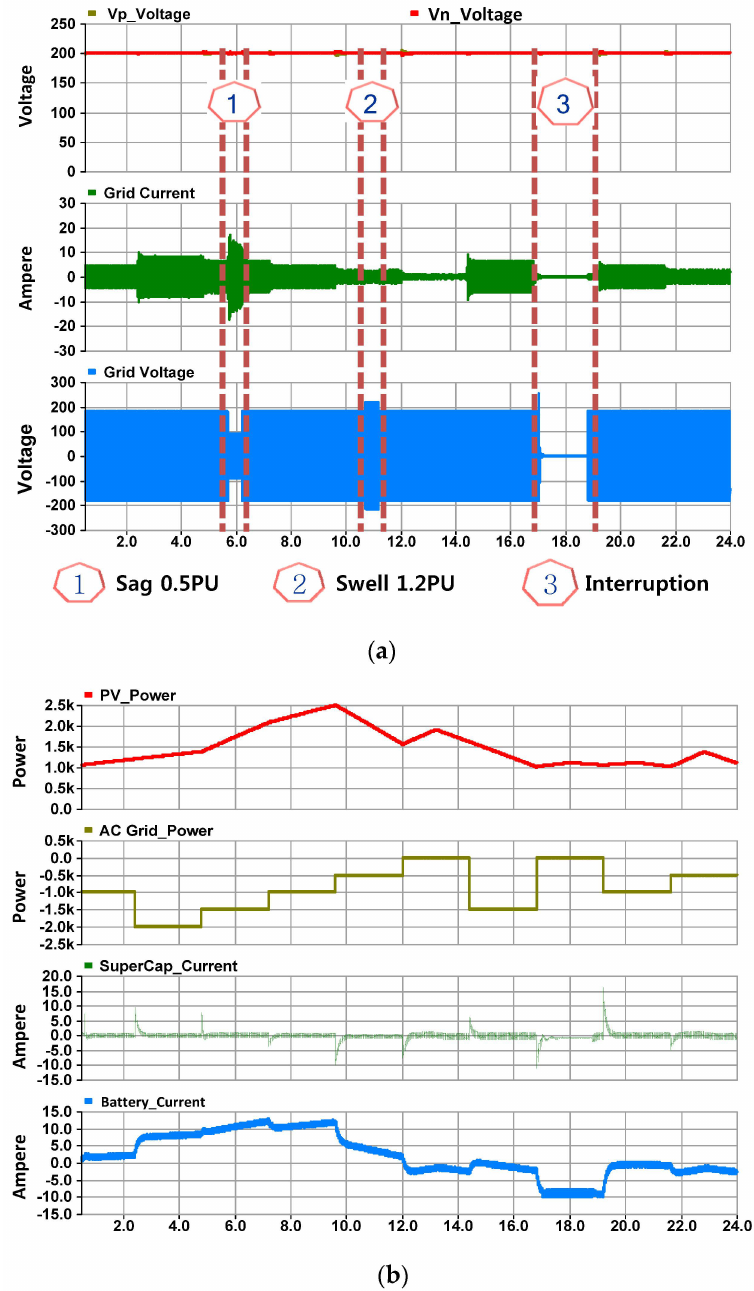
Figure 14. Simulation results for operation analysis: ( a ) DC voltage and AC grid current & voltage; ( b ) PV power, bulk power, SC current, BAT